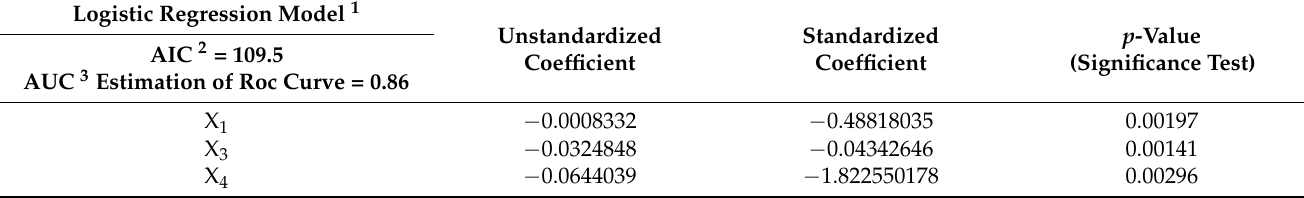
Table 4. The logistic regression summary of the dependent variables of market town sites. Logistic Regression Model 1